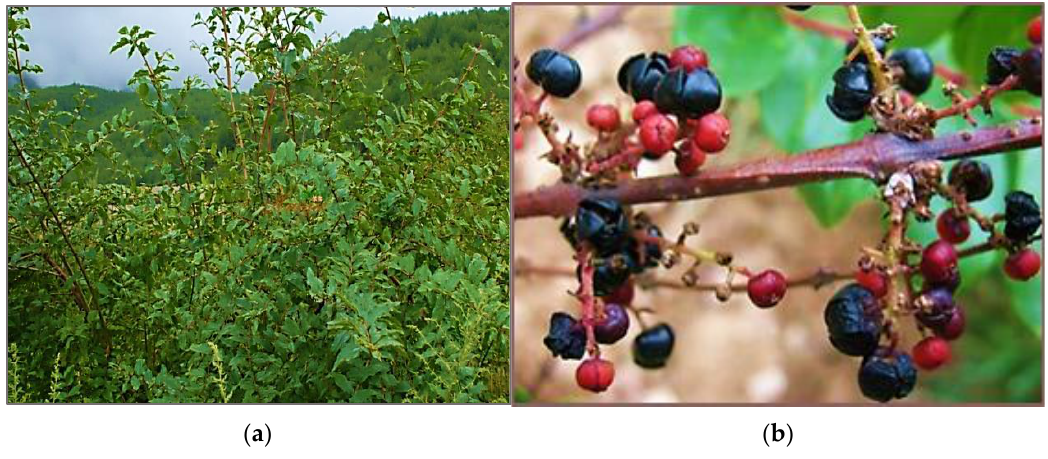
Figure 1. ( a ) Vegetative part of the plant and ( b ) fruit twig. The sodium hydroxide extract of Coriaria nepalensis bark showed a significant amount of tannin and is reported to be a renewable source [28]. The methanolic extract has been reported to be more bacteriostatic than essential oil obtained from the leaves of this shrub [29]. The chloroform extract obtained from this plant’s root is exploited to isolate new compounds such as sesquiterpene lactone, corialactone E, neolignan, coriarianeolignan, and apocarotenoids [30]. Among many phytochemicals, 4-Pyrimidinecarboxylic acid and Dihydrocorynantheine are the two most common alkaloids in C. nepalensis given in Scheme 1 [29,31].